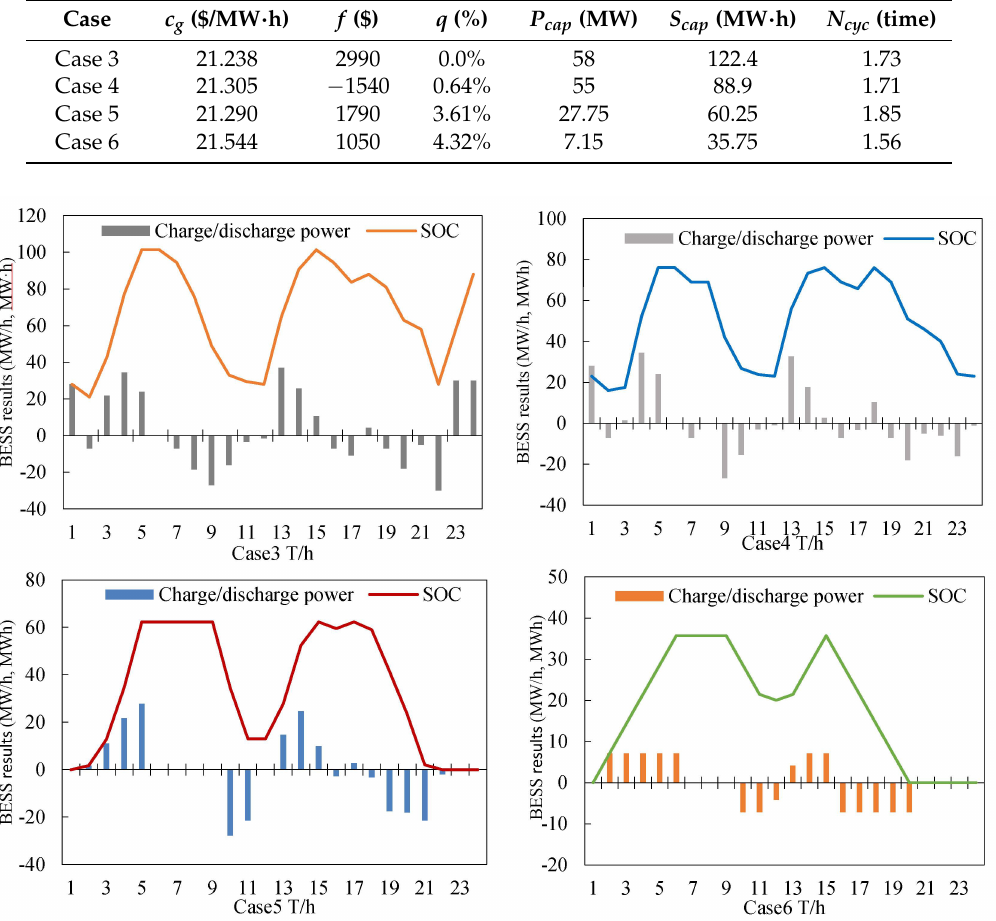
Figure 7. Charge/discharge process of BESS under different cases. SOC: state of